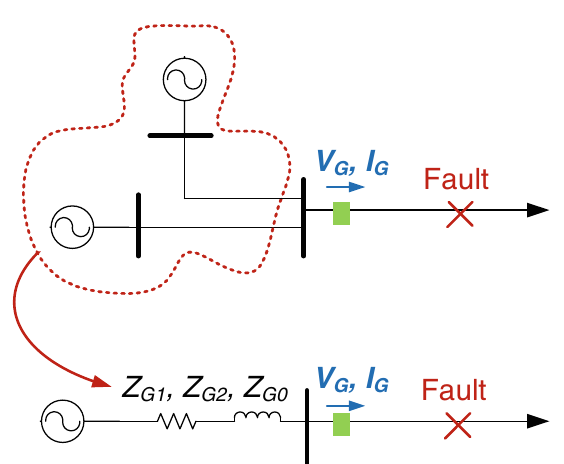
Fig. 7 Concept of Thevenin impedance. The effect of the impedance of the upstream network can be emulated by replacing it with an equivalent impedance and this equivalent impedance is called Thevenin impedance